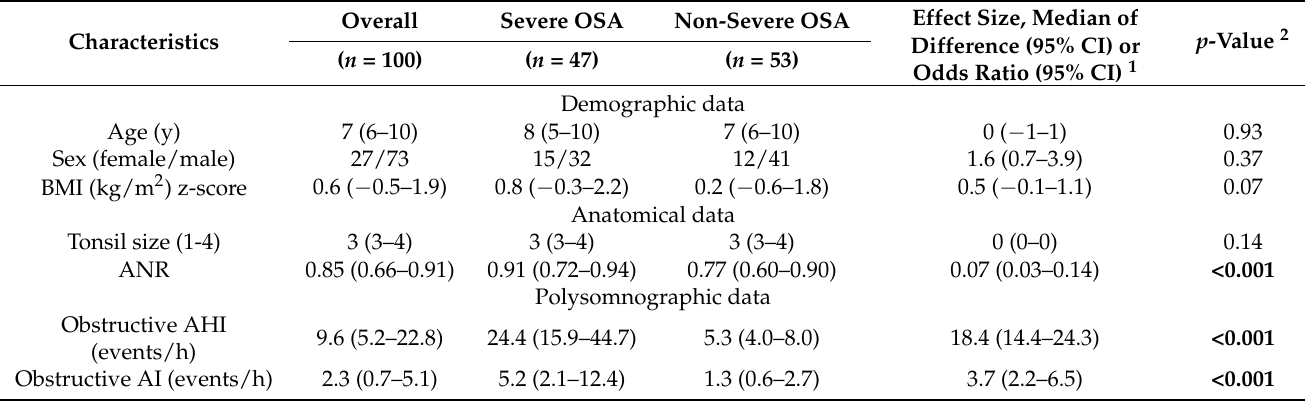
Table 5. Patients’ characteristics of Study